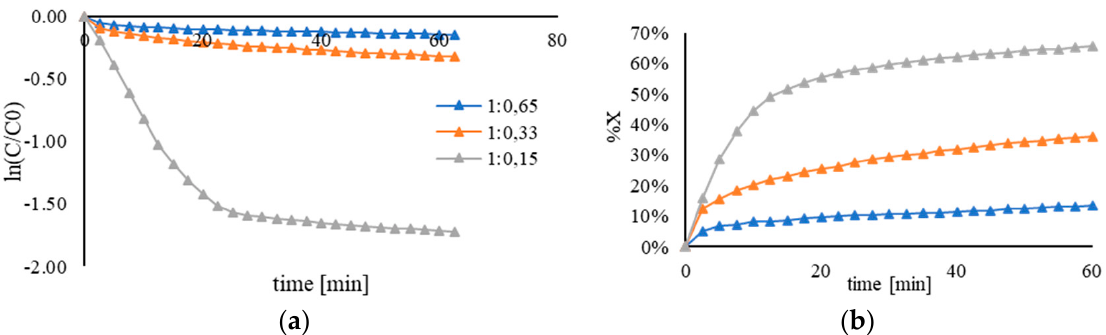
Figure 3. ( a ) Kinetic plot for pseudo–first–order reaction and ( b ) conversion plot using Au/AC synthesized using full hydrolyzed PVA2 (Mw = 13,000–23,000) by varying the Au/PVA weight ratio. Reaction carried out by using 25 mL of 4-NP (2 × 10 − 4 M) and 25 mL of NaBH 4 (9 × 10 − 3 M), at 25 °C and different PVA amounts: 0.65 mL (Au/PVA ( w / w ) = 1:0.65), 0.33 mL (Au/PVA ( w / w ) = 1:0.33), 0.15 mL (Au/PVA ( w / w )= 1:0.15). Table 8. Values of the apparent constant and conversion for pseudo-first-order reactions using full hydrolyzed PVA2 (Mw = 13,000–23,000) by varying the Au/PVA weight ratio.